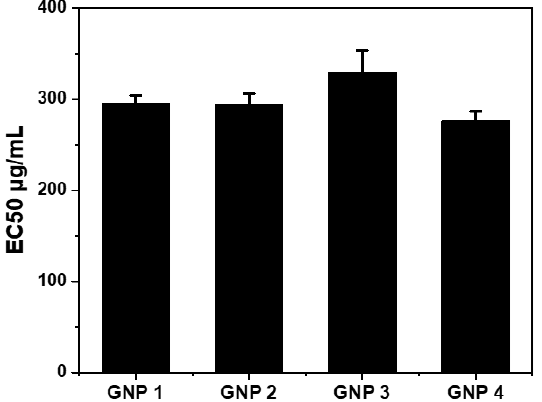
Figure 6. Cytotoxicity of GNPs. EC50 values of A549 cells treated with GNPs (based on Figure S2). After treatment with GNPs 48 h, cells were analyzed by CellTiter-Glo ® assay through luminescence. Error bars indicate mean ± standard deviation (n = 3).